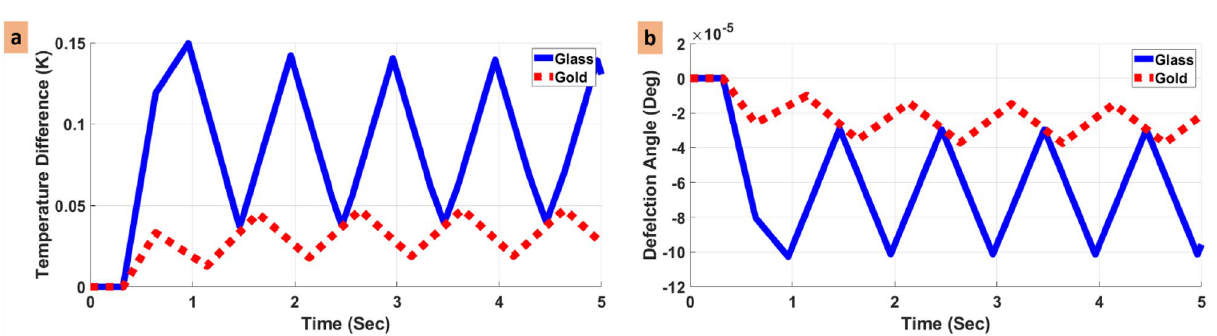
Figure 2. ( a ) Temperature difference and ( b ) deflection angle for the glass and Au substrates in the vicinity of